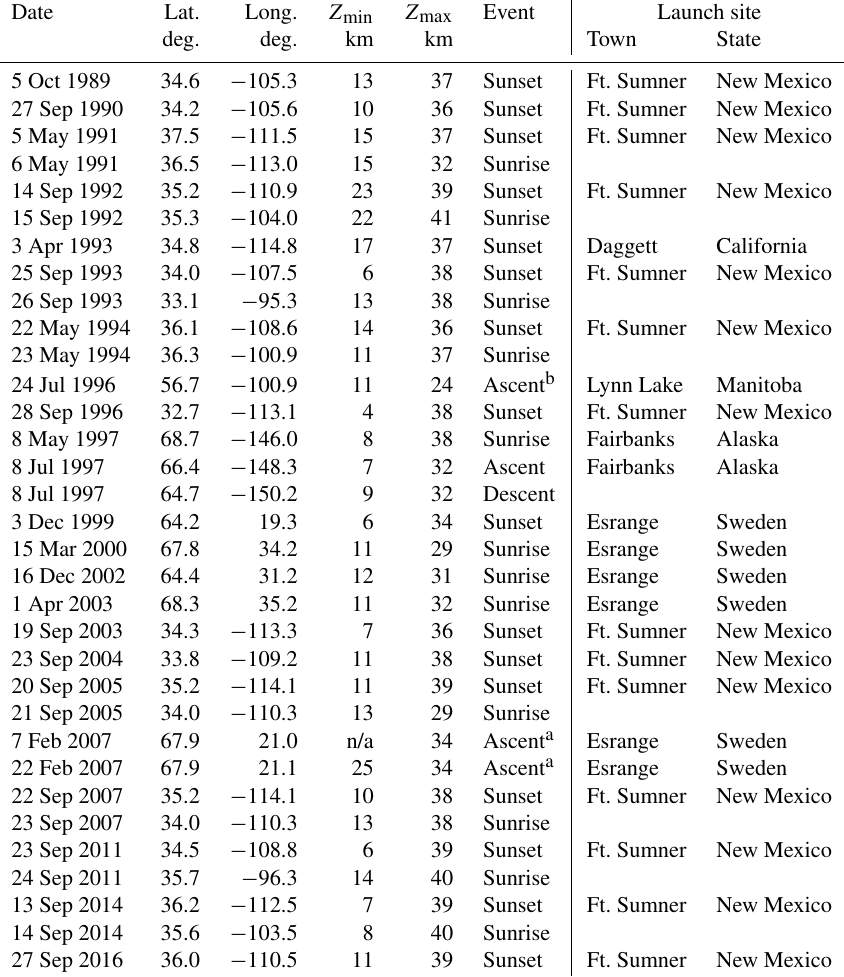
Table 1. Summary of MkIV balloon occultations. Lat. and Long. represent the latitudes and longitudes of the 20km tangent point. Z min and Z max represent the altitudes over which the tangent altitude varied. Flights flagged by a or b in the Event column acquired no useful data. Lat.